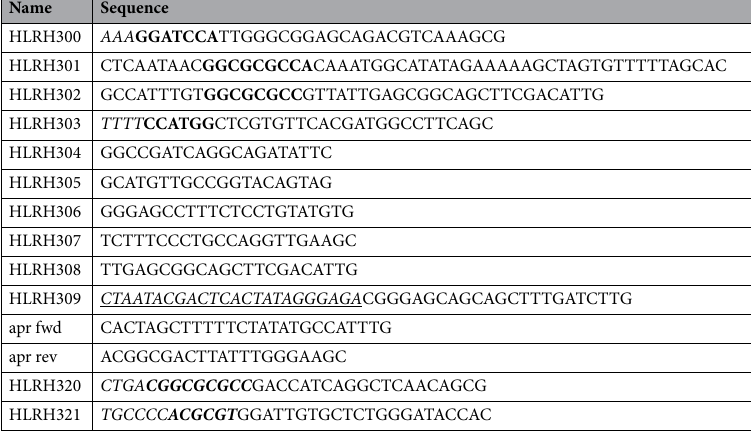
Table 2. Primers. Primer extensions are presented in italics and restriction sites in bold letters. The T7 RNA polymerase promoter is underlined and presented in